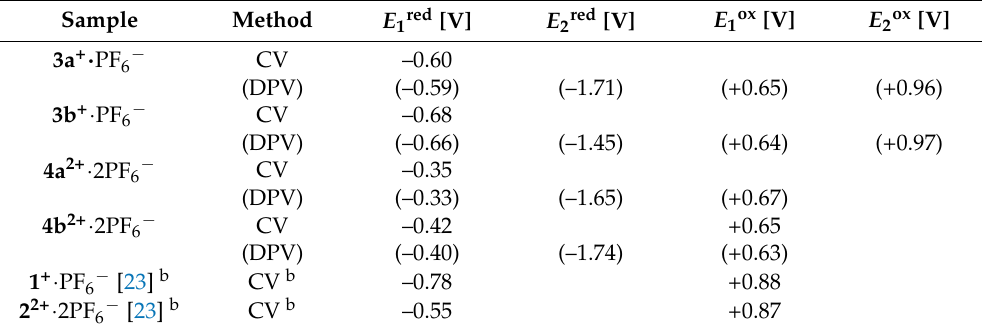
Table 3. Redox Potentials a of 3a , b + · PF 6 − , 4a , b 2+ · 2PF 6 − , 1 + · PF 6 − , and 2 2+ · 2PF 6 − in